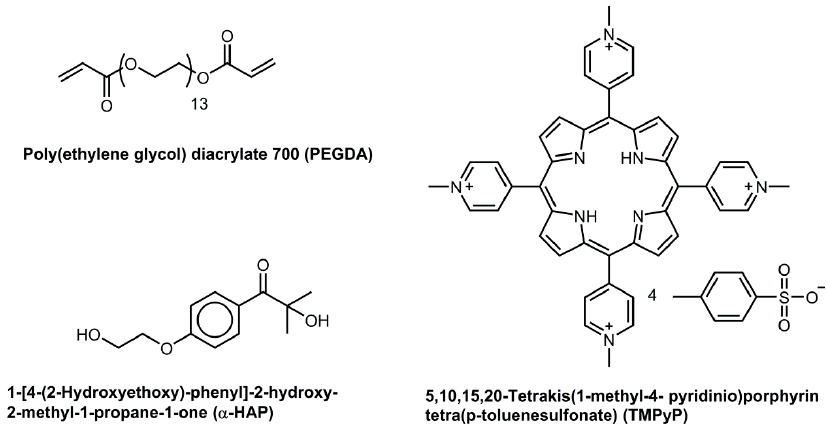
Figure 1. Molecular structures of the chemicals used during the study.